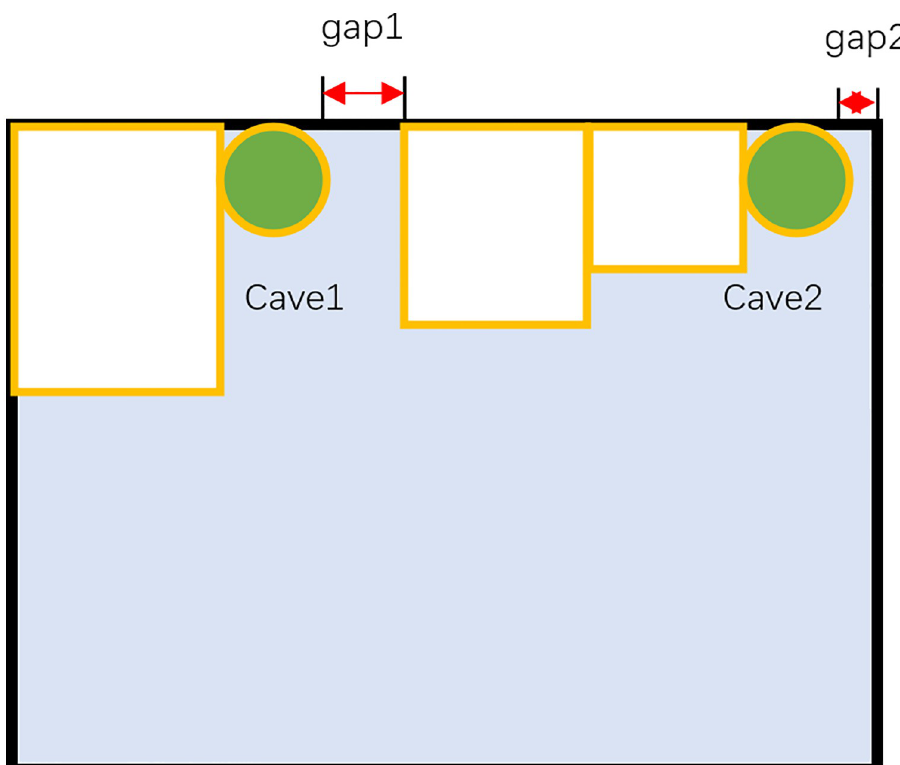
Fig 9. The diamond cave. The white parts are the parts already placed in the bin, and the green circular part is the part to be placed. There are two caves in the bin. Placing the green circular part in cave 2 leaves a smaller gap, so cave 2 is defined as a diamond